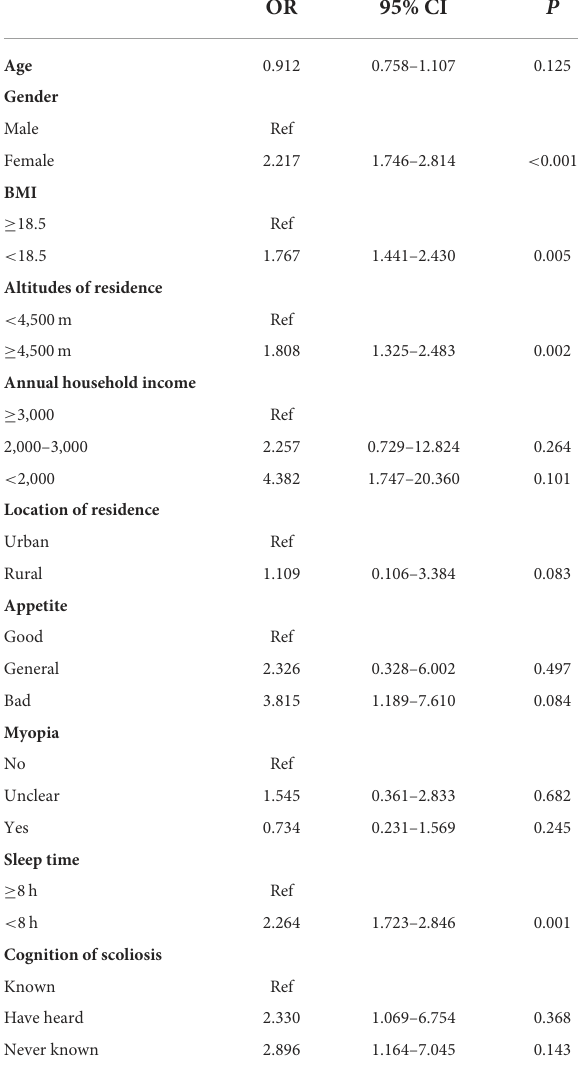
TABLE 3 Associated factors with scoliosis by multivariate logistic regression